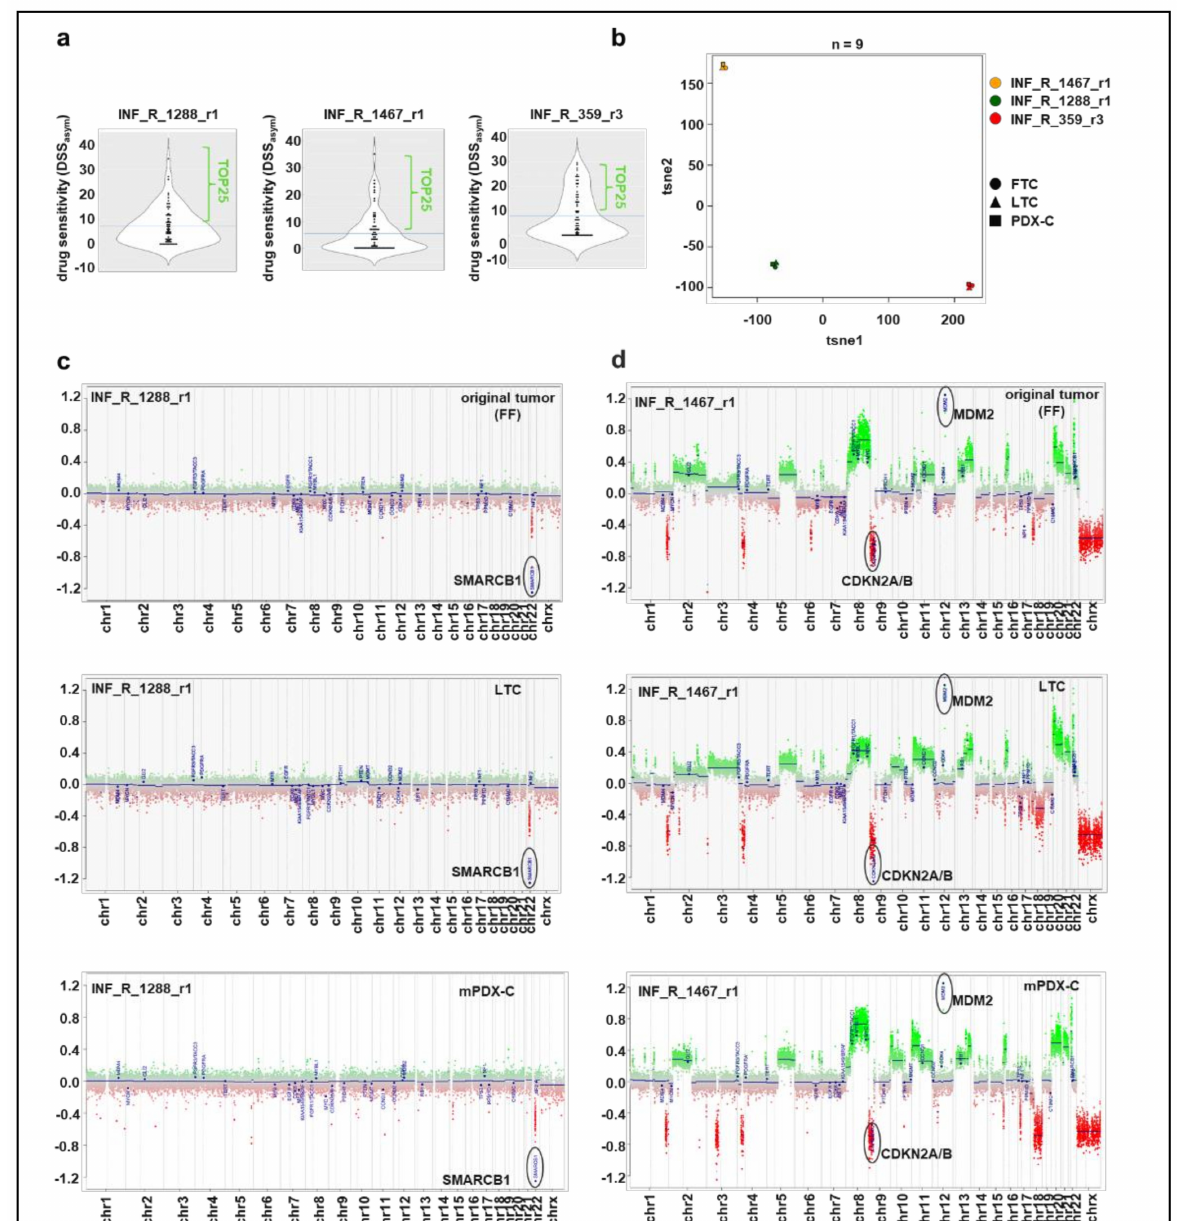
Figure 1. Comparison of the original tumor with matched culture models. ( a ) Overall drug sensitivity (DSS asym ) against 76 clinically relevant drugs of the three patient-derived samples (FTCs), measured with CellTiterGlo metabolic activity assay. Horizontal line reflects the mean. ( b ) t-SNE analysis of DNA methylation profiles for comparison of the original tumors and their tumor-derived culture models LTC and mPDX-C. ( c ) Copy-number profiles of the original rhabdoid tumor INF_R_1288_r1, and its LTC and mPDX-C models reveal similar genome-wide methylation patterns and recurrent SMARCB1 deletion, characteristic for rhabdoid tumors. ( d ) Copy-number profiles of the original eRMS tumor INF_R_1467_r1, and its LTC and mPDX-C models reveal similar genome-wide methyla- tion patterns and recurrent high-level MDM2 amplification, CDKN2A/B deletion, LOH and instable genome. FTC: fresh tissue culture; FF: fresh frozen; LTC: long-term culture; mPDX-C: mouse-PDX- derived culture; LOH: loss of